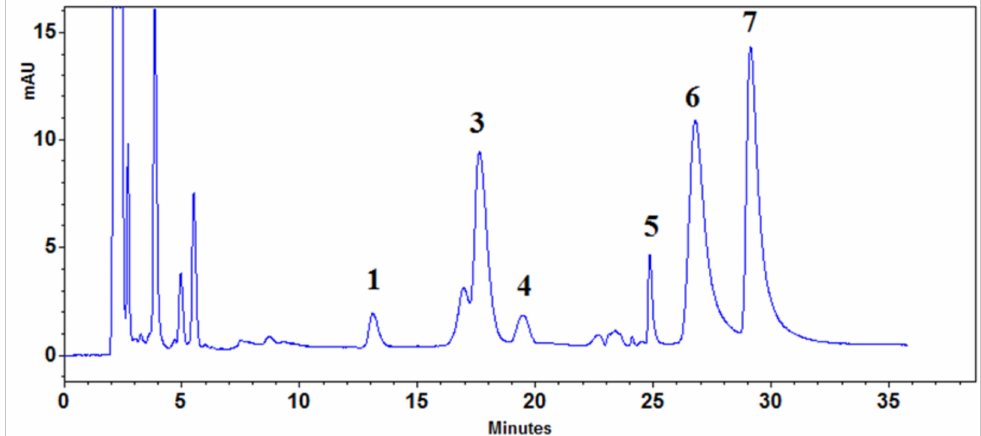
Figure 5. Example of 2D chromatograms obtained using a combination of three monolithic